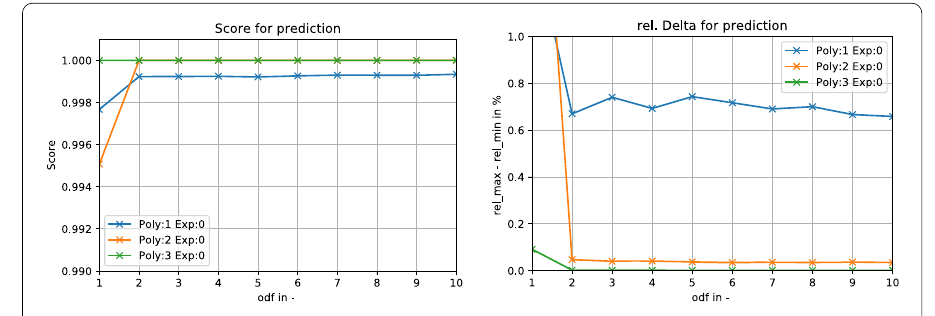
Fig. 22 Beam with holes: convergence of quality measures RSME-Score and (cid:2) rel for beam with